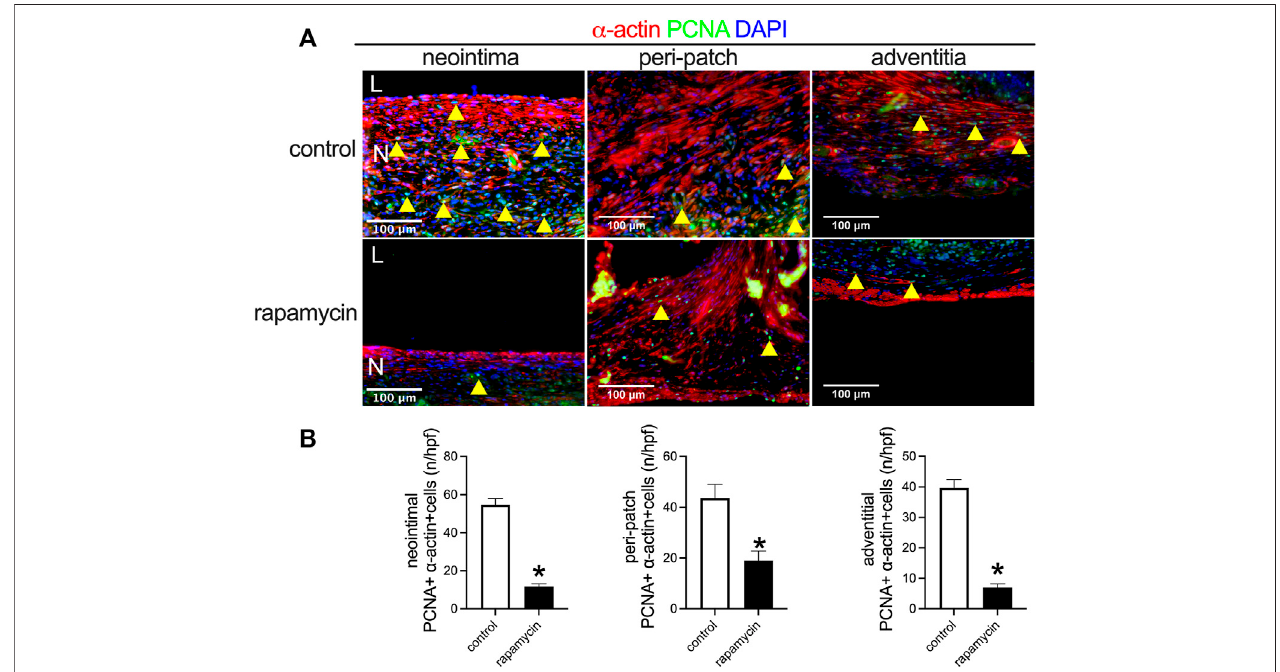
FIGURE 6 | Rapamycin inhibits neointimal smooth muscle cell proliferation. (A) Immuno fl uorescence showing PCNA (green), α -actin (red), and DAPI (blue) in the neointima; scale bar 100 μ m; yellow arrowheads show PNCA-positive cells. (B) Bar graphs showing quanti fi cation of PCNA-positive cells (*, p = 0.0003, t -test) in the neointima (* p = 0.0073, t -test); n = 3.